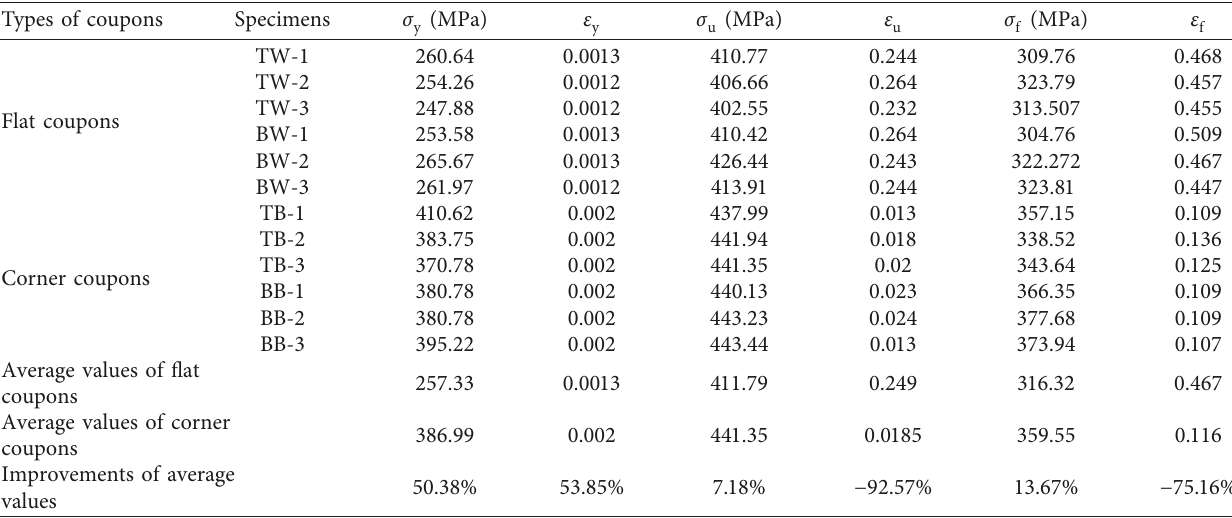
Figure 9: Comparison of engineering stress-strain curves of flat and corner Table 1: Mechanical parameters of engineering stress-strain curves.